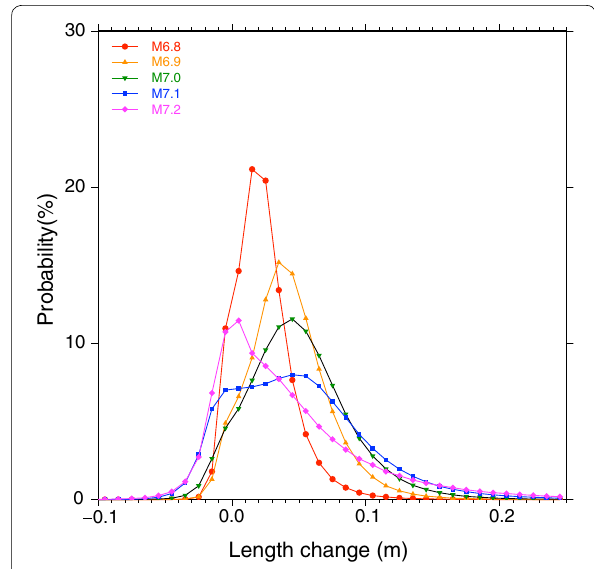
Fig. 5 Monte Carlo simulation results for the length change of the Shionohara baseline due to the 1894 Shonai earthquake. Each curve shows a probability distribution of expected baseline length change for different moment magnitude obtained from 1 million test cases